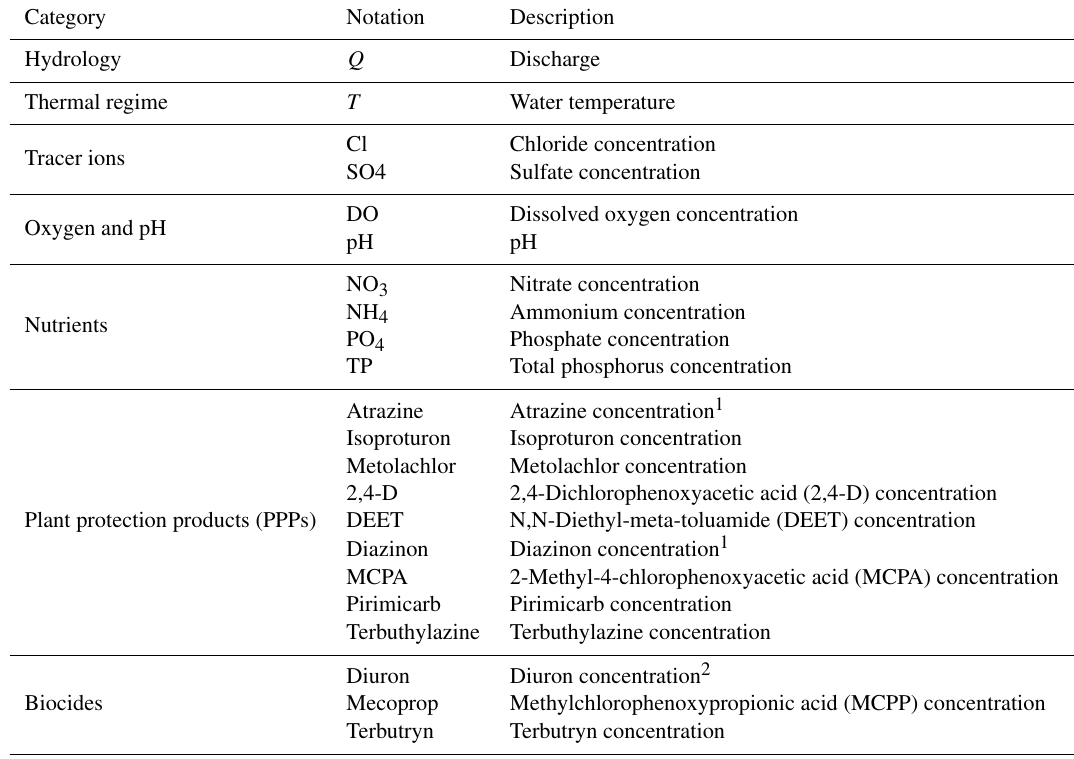
Table 1. Water quantity and quality variables modelled in the case